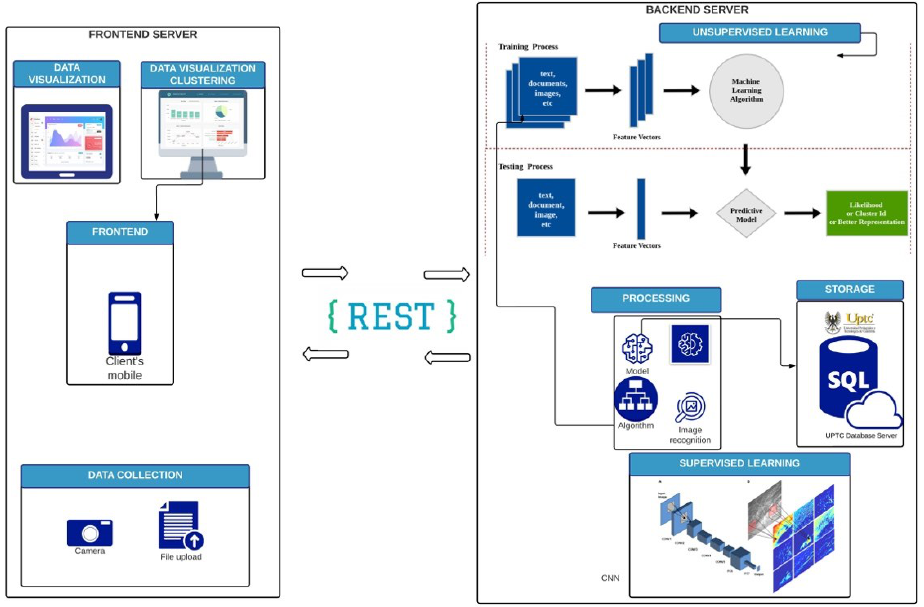
Figure 2. Functional architecture.